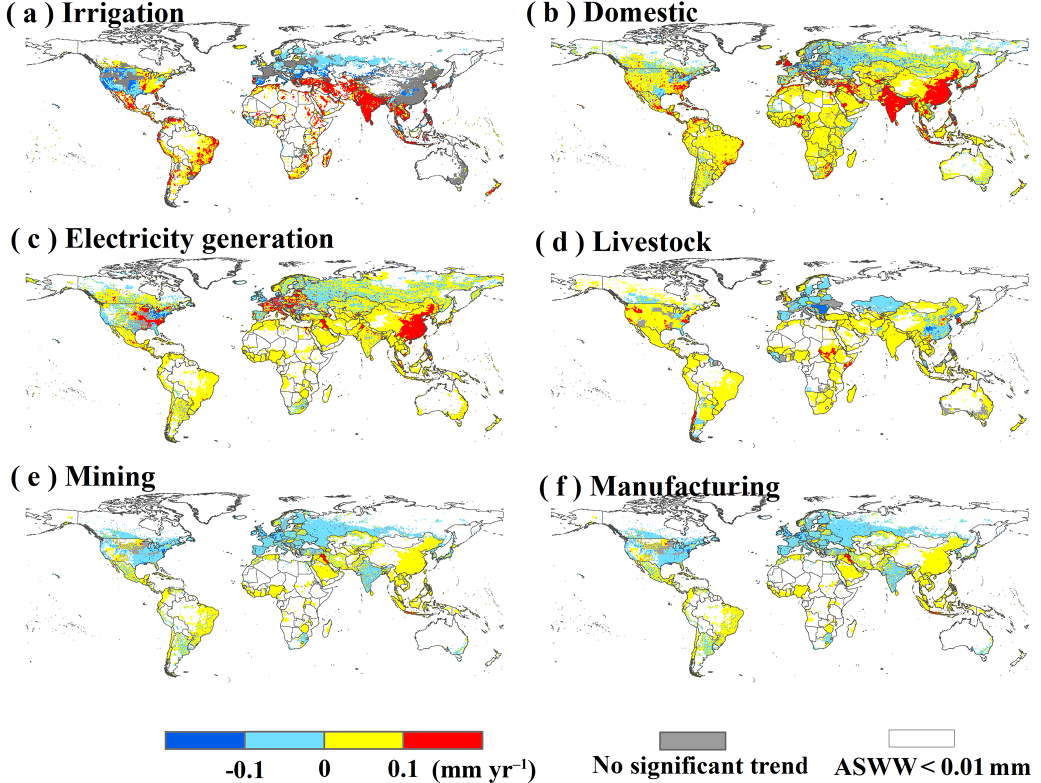
Figure 7. Trend of global gridded water withdrawal by sectors: (a) irrigation, (b) domestic, (c) electricity generation, (d) livestock, (e) mining, and (f) manufacturing, grids with annual sectoral water withdrawal (ASWW) less than 0.01mm are not taken into